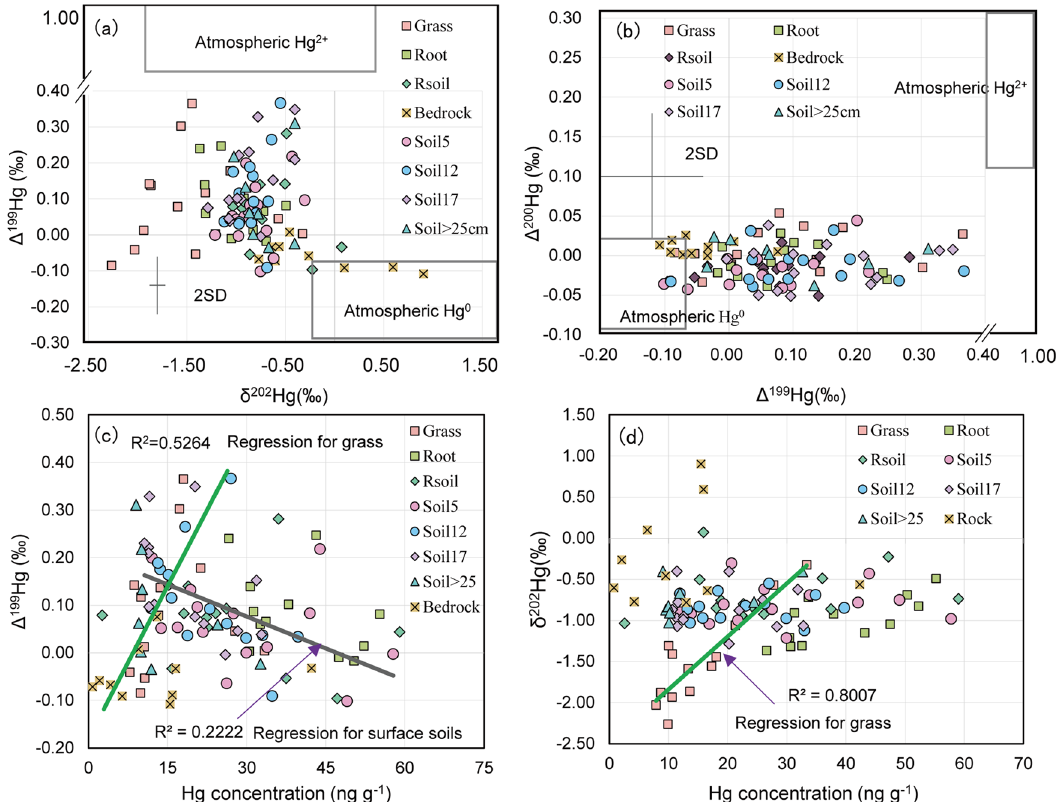
Fig. 3 Relationships between different mercury (Hg) and isotopic compositions. a Δ 199 Hg versus δ 202 Hg, b Δ 200 Hg versus Δ 199 Hg, c Δ 199 Hg versus Hg concentration, d δ 202 Hg versus Hg concentration. Two standard deviations are showed in a and b . The green line in c represents the regression between Δ 199 Hg and Hg concentration for grass foliage samples, and gray line represents the regression between Δ 199 Hg and Hg concentration for 0 − 17 cm depth of surface samples. The green line in d represents the regression between δ 202 Hg and Hg concentration for grass foliage samples. The atmospheric Hg 2 + isotopic compositions in the QTP can be found in Supplementary Table 1, and the range of atmospheric Hg 0 isotopic composition is based on literature synthesis 19,40 and for the QTP region can be found in Supplementary Table